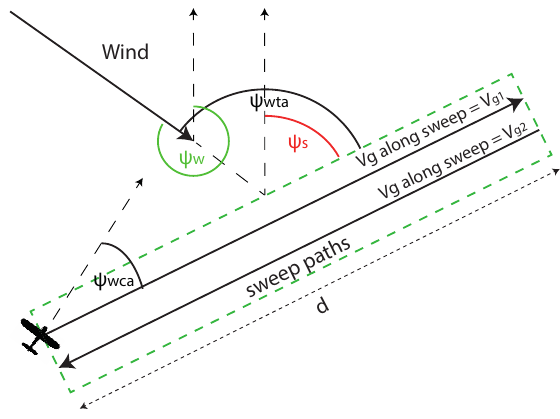
Figure 5. The illustration of a scenario designed to show that flying perpendicular to the wind is always faster than directly into it along the sweep portion of the